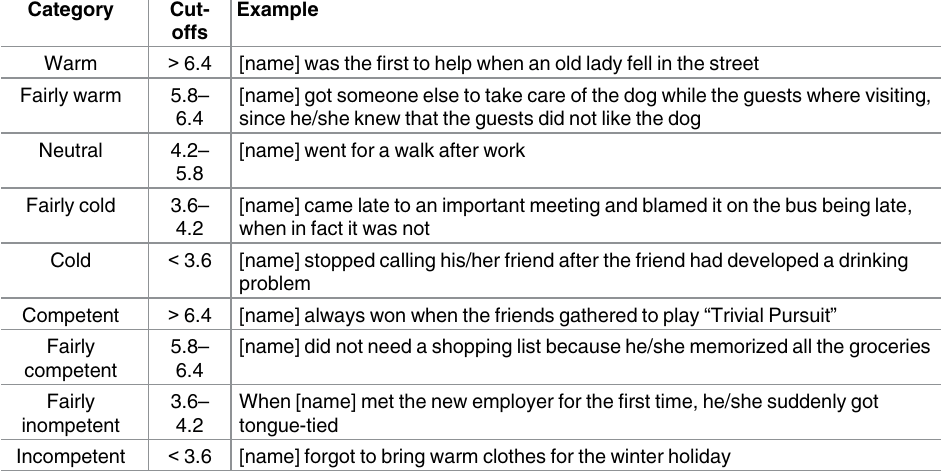
Table 1. Examples of warmth and competence-related behaviors, including cut-off scores for each